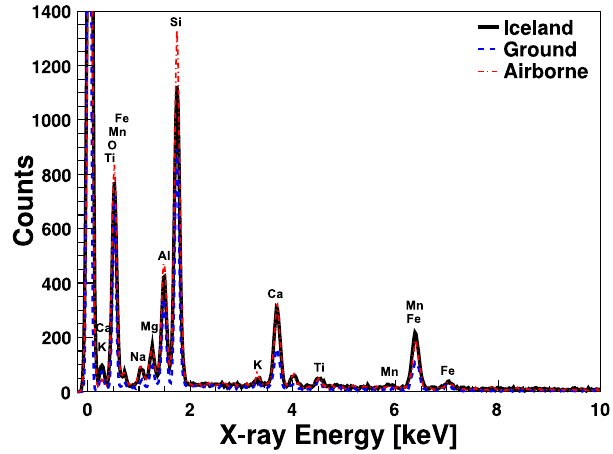
Fig. 11. Energy dispersive X-ray spectrum of the reference ash sample obtained from Iceland (full black line) and the ash sample collected in the ground-based (dashed blue line) and airborne (dotted red line) measurements in Slovenia. The reference sample was collected in the southern part of Iceland, about 50 km away from the Eyjafjallajökull volcano, after the main eruption.